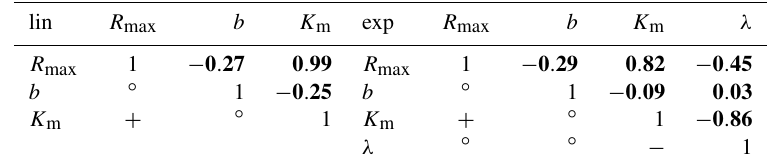
Table C3. Correlations between the derived parameters.